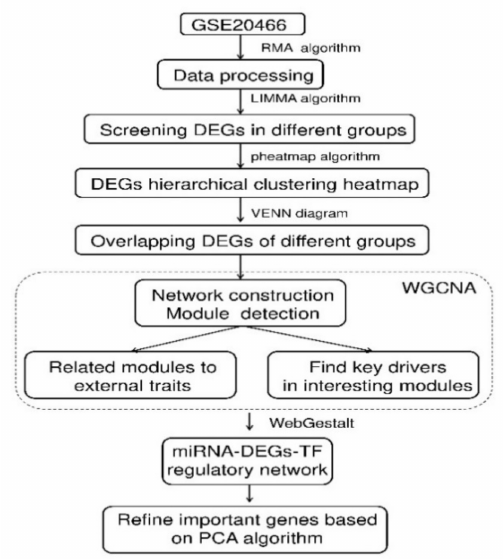
Figure 9. Schematic illustration of the analysis